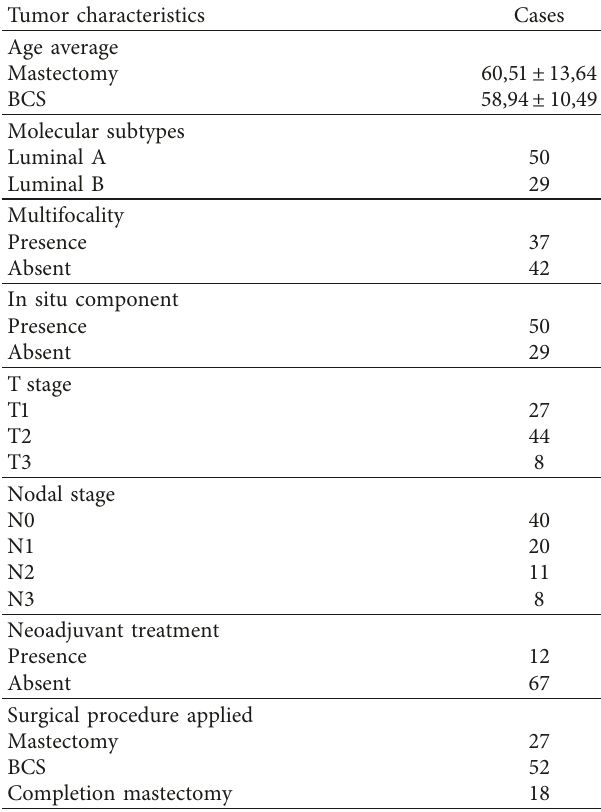
Table 1: Clinical and biological characteristics of the